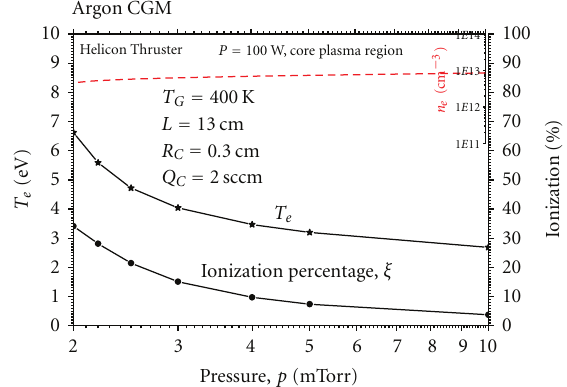
Figure 17: Calculated n e , T e , and ionization percentage versus pressure in the core plasma region of a helicon